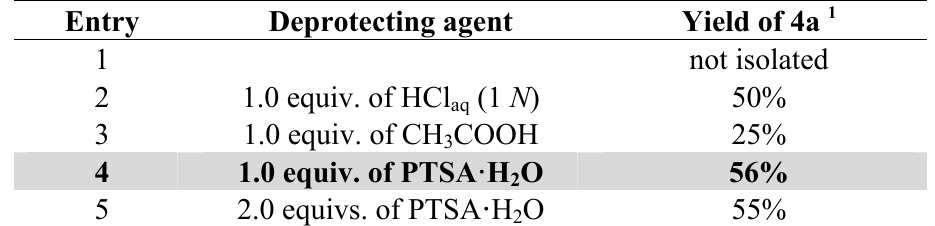
Table 3. Optimization study for the one-pot synthesis of 3-( p -anisyl)-1 H -pyrazole ( 4a